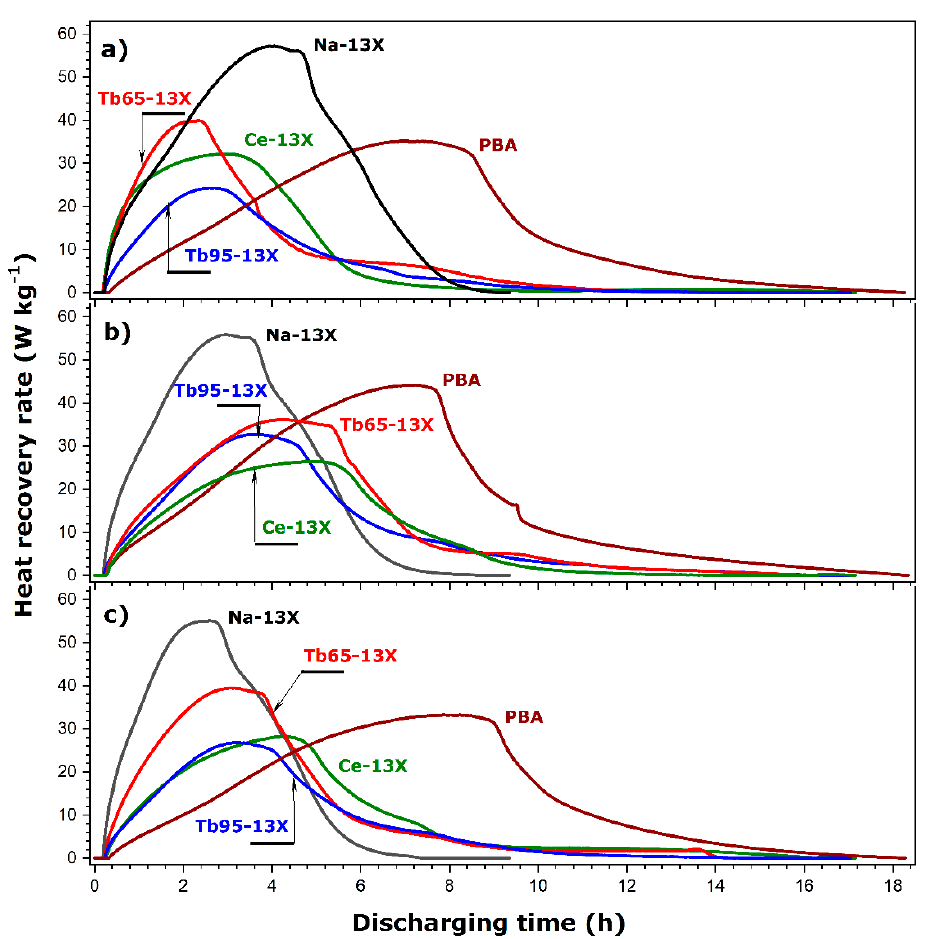
Figure 5. Kinetics of gradual heat release upon adsorption of water vapor in three representative saturation cycles: ( a ) first saturation cycle, ( b ) saturation cycle after a long-time heating step, ( c ) saturation cycle after a short-time heating step.